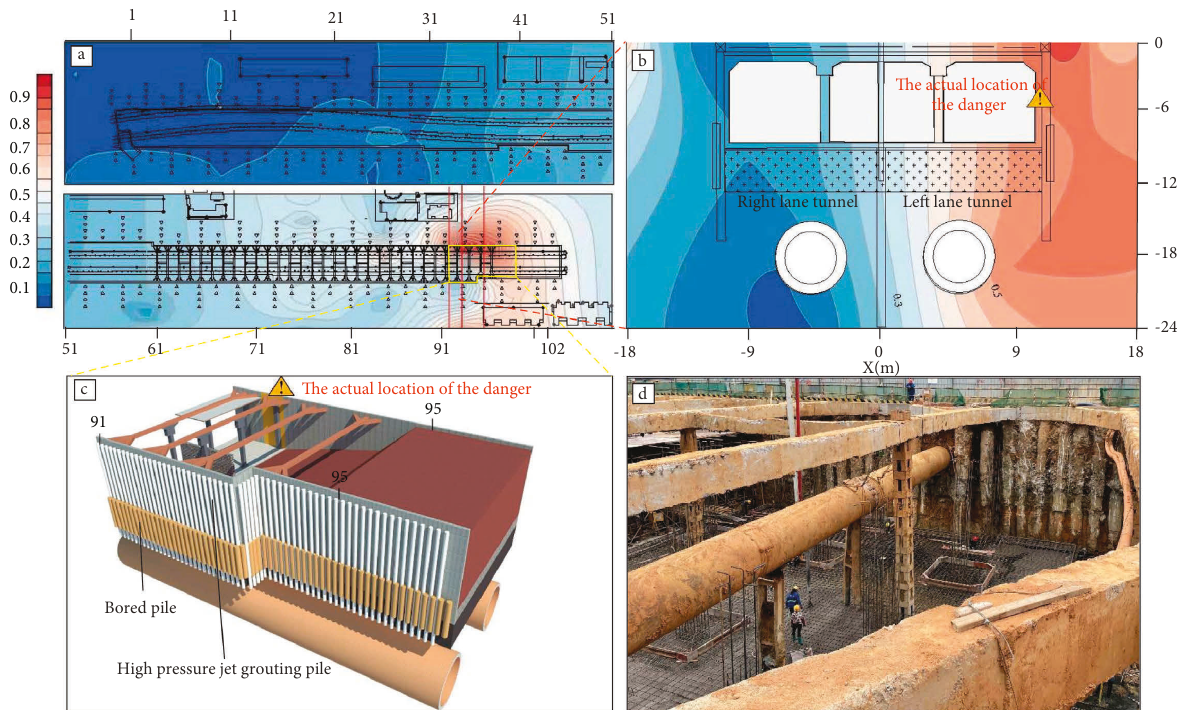
Figure 14: Comparative analysis of the third risk assessment and the actual situation: (a) risk distribution assessment plan; (b) risk distribution assessment sectional view; (c) construction status and actual location of the accident at the time of the third accident; (d) the scene of the third